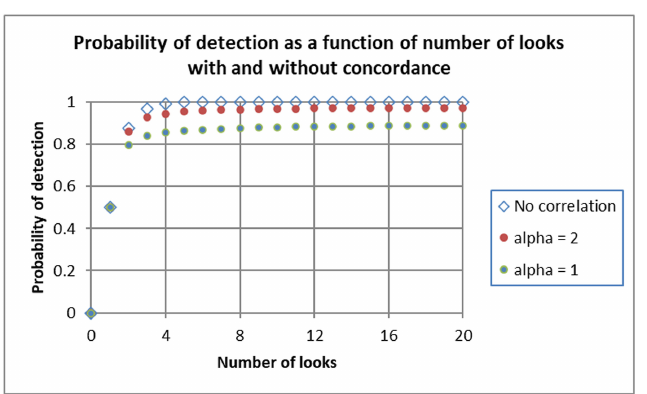
Figure 16. Probabilityofdetection asafunctionofnumber of looks with and without concordance assuming g ð x Þ ¼ sin ð x Þ